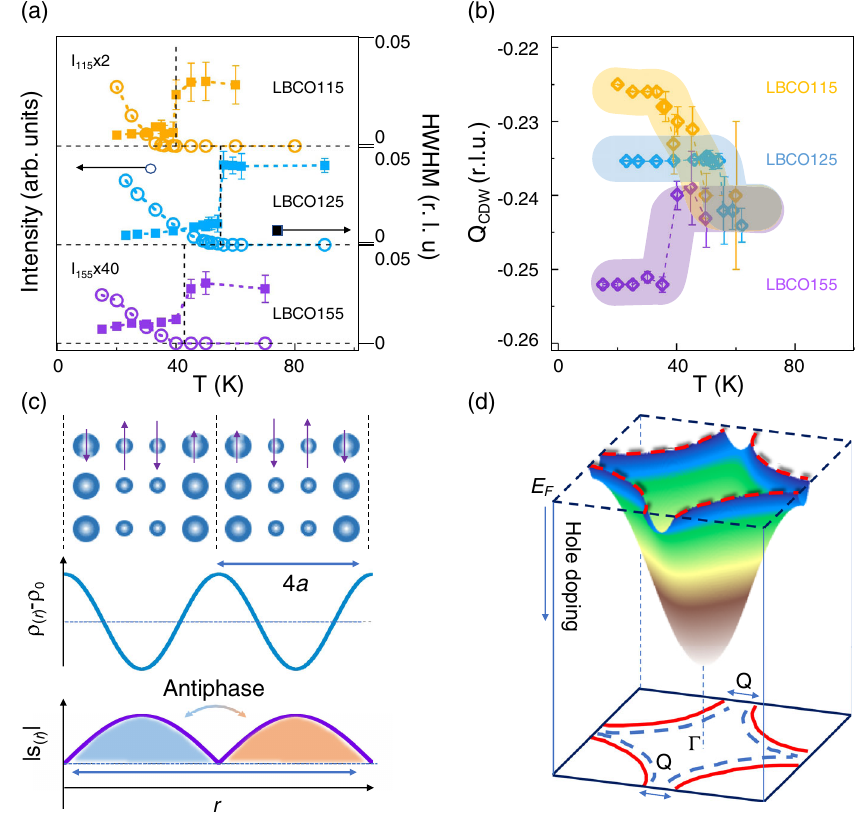
FIG. 4. Universal PCDW. The extracted peak intensity (left axis) and HWHM (right axis) of the PCDW and LCDW are shown in (a). The vertical dashed lines at 38, 55, and 40 K represent the LCDW critical temperature of LBCO115, LBCO125, and LBCO155, respectively. Above these temperatures, both the peak intensity and the HWHM remain unchanged within the error bars. (b) shows the extracted temperature-dependent CDW wave vectors. Note that our measurement is performed at negative Q to enhance charge PCDW excitations [9,16]. The shaded yellow, blue, and purple curves are guides to the eye for LBCO115, LBCO125, and LBCO155, respectively. In the PCDW phase, the wave vectors are doping independent. (c) schematically shows the “ stripe ” picture from the mean- field theory. Blue circles and purple arrows represent the local hole and spin density, respectively. Antiphase spin density wave (SDW) j ¼ 2 δ ∼ 2 x relation. (d) schematically shows the FS-driven domains are separated by charge stripes and give rise to the j Q CDW SDW mechanism. Since the FS shrinks at higher hole doping, this model predicts smaller CDW wave vectors at higher